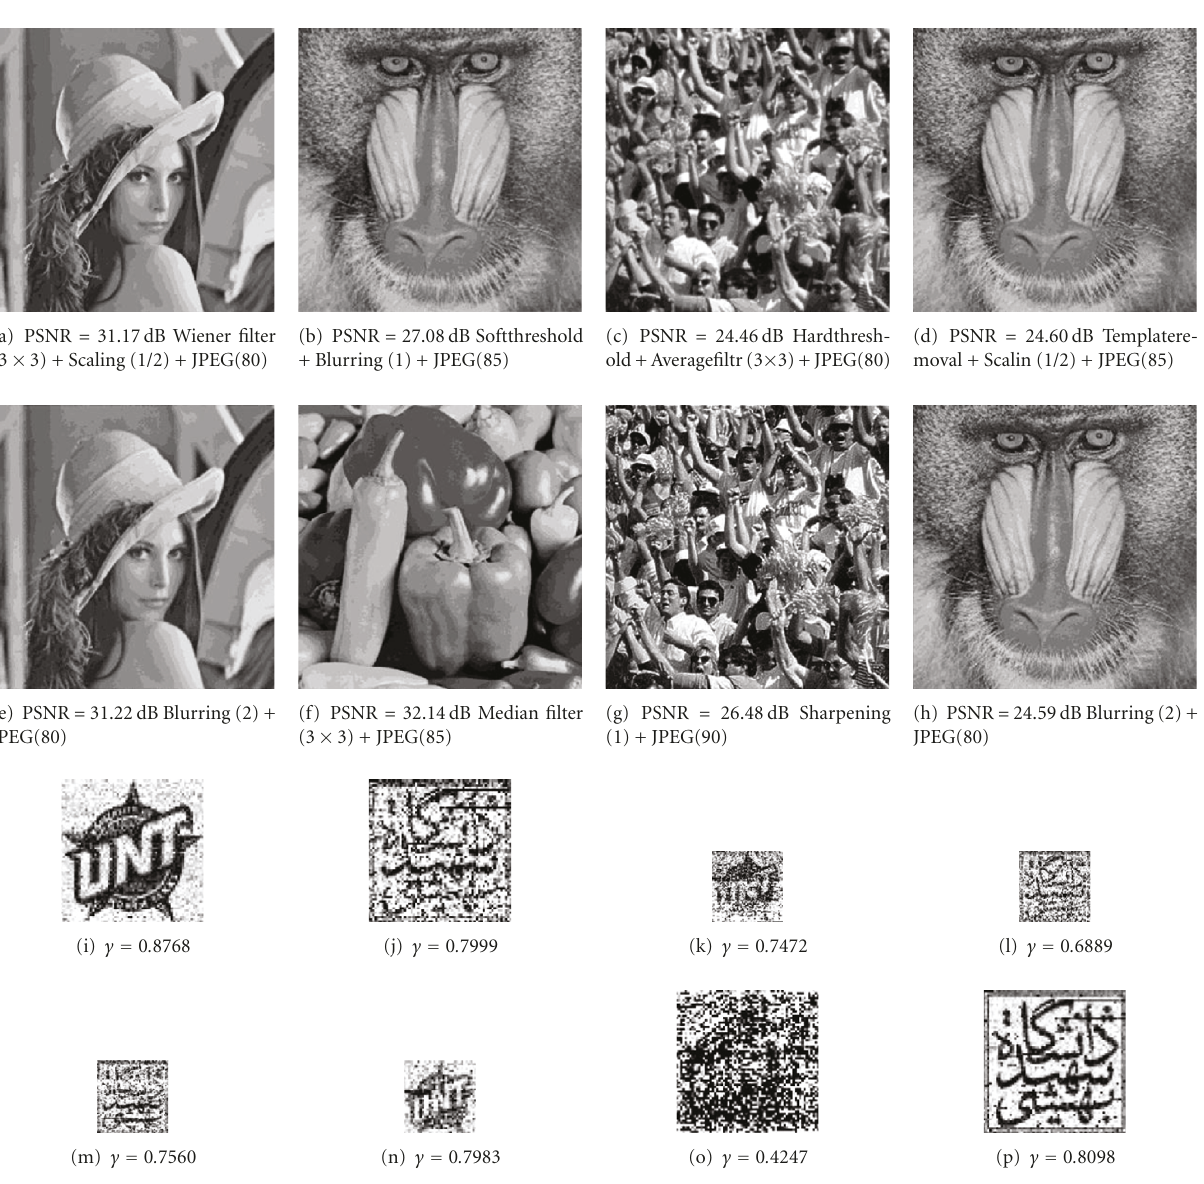
Figure 29: (a)–(h) The watermarked image after di ff erent composite attacks, (i)–(k) The extracted watermark from (a)–(h), respectively.